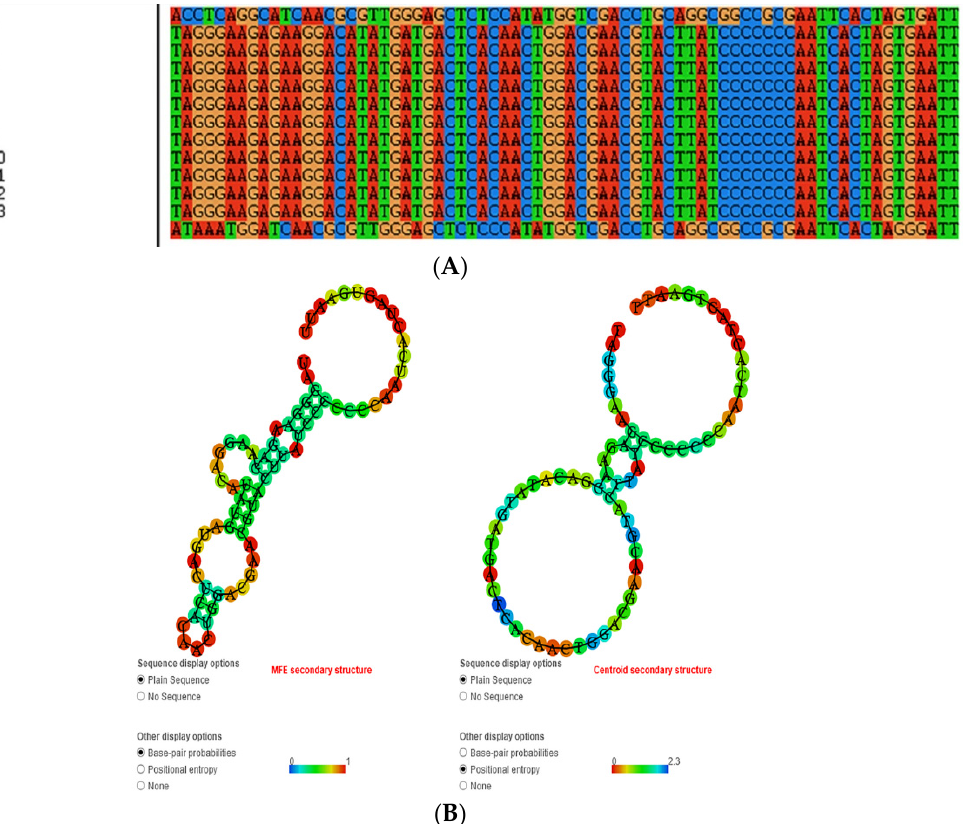
Scheme 1. ( A ) The alignment of RIV-specific DNA aptamers. ( B ) The 76-mer ssDNA aptamer’s secondary structure. M-Fold software used the free minimization approach to anticipate the structure. The likelihood is shown by the color annotation.